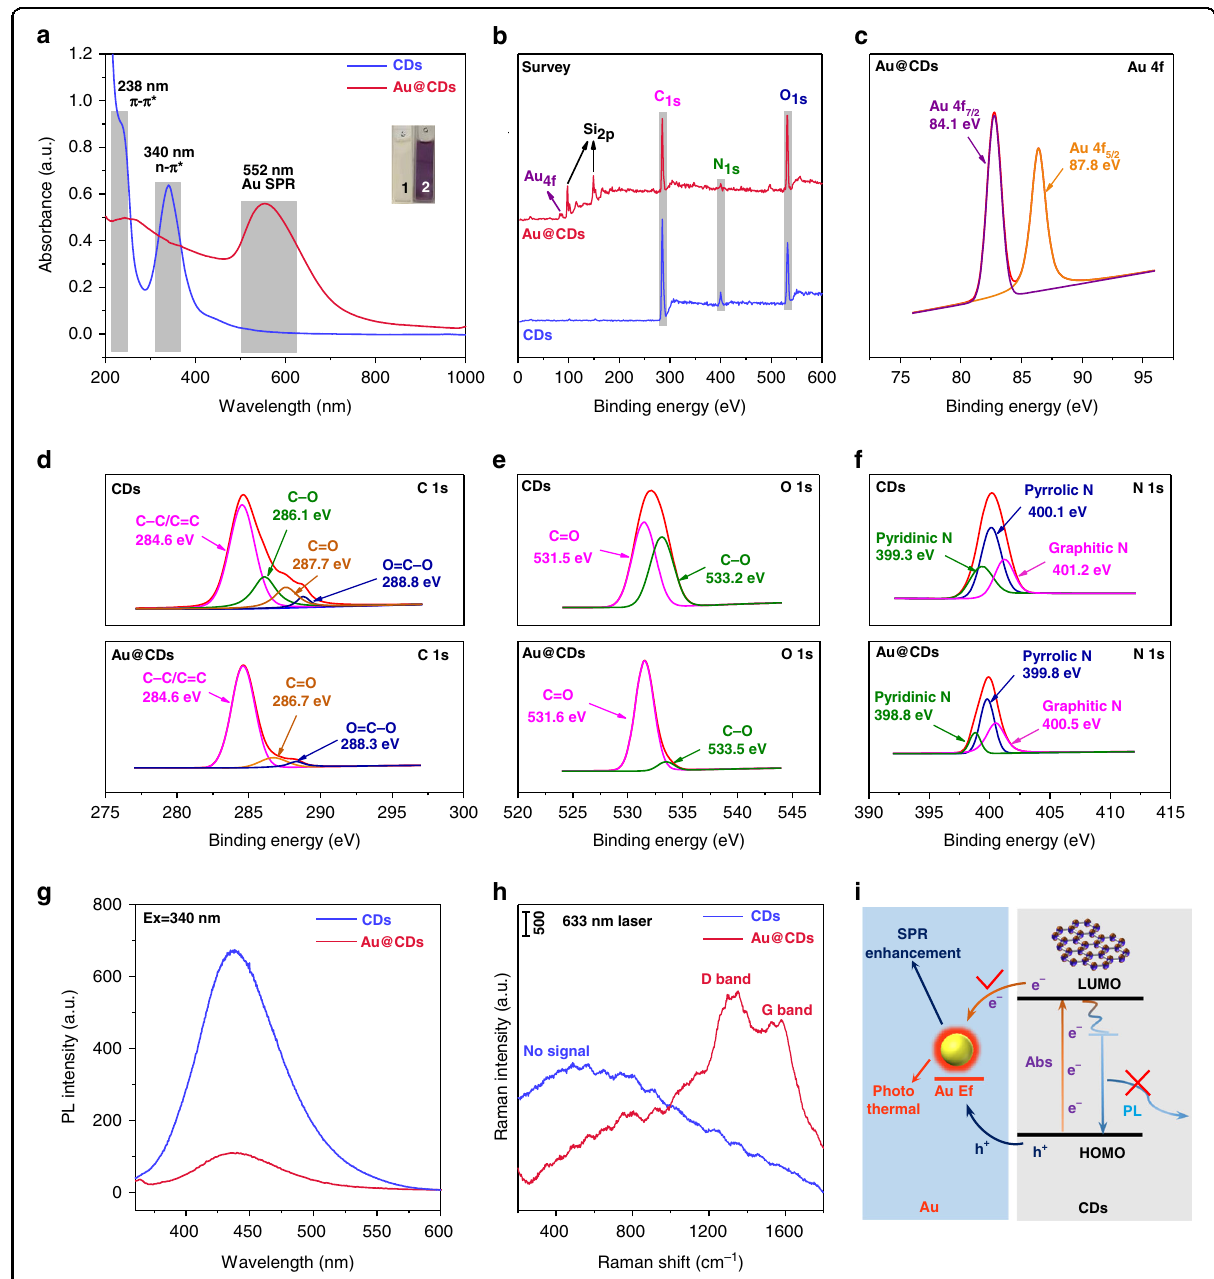
Fig. 2 Structural characterization of CDs and Au@CDs. a UV-vis-NIR absorption spectra of CDs and Au@CDs in aqueous solution, (inset: the solution color of (1) CDs and (2) Au@CDs under natural light). XPS spectra of CDs and Au@CDs: b full survey spectrum, c Au 4f, d C 1s, e O 1s, f N 1s. g Photoluminescent spectra (under 340 nm excitation) and h Raman spectra of CDs and Au@CDs in aqueous suspension. i Description of the CT effect in Au@CDs